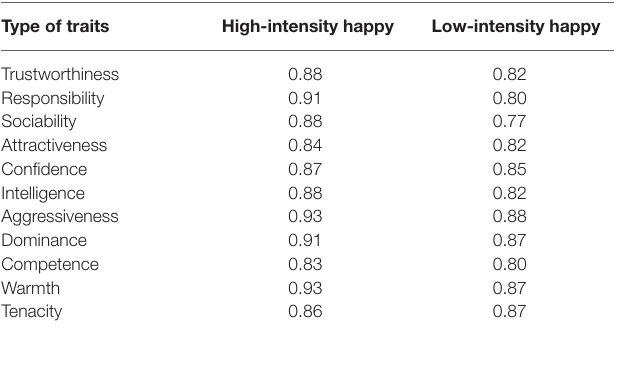
TABLE 3 | The Cronbach alphas of 11 trait rating scores. Type of